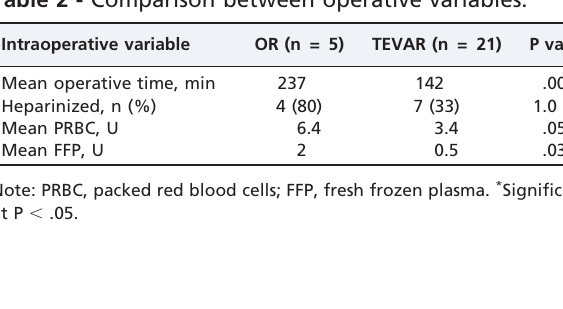
Table 2 - Comparison between operative variables.